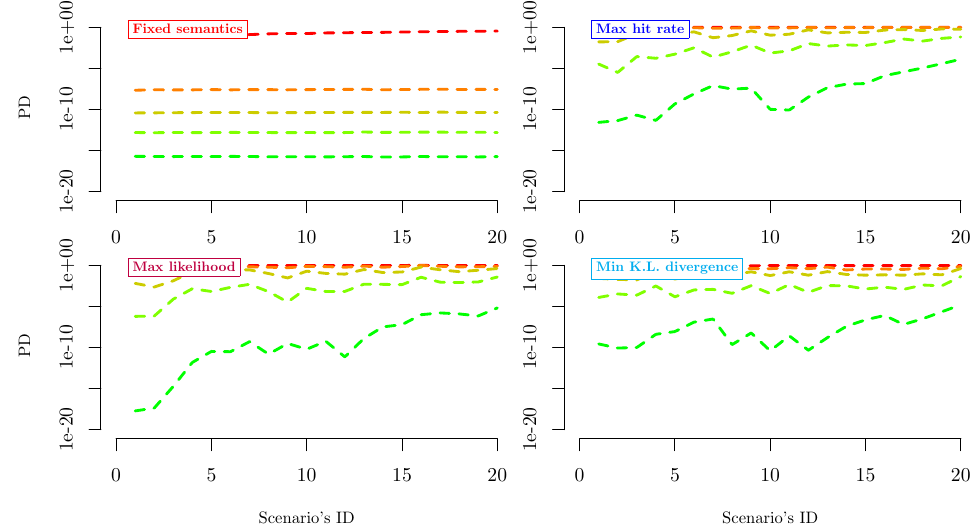
Figure 4. Average PD per notch across the considered scenarios. Each panel depicts the effects of choosing a different optimization criterion among the ones defined in Section